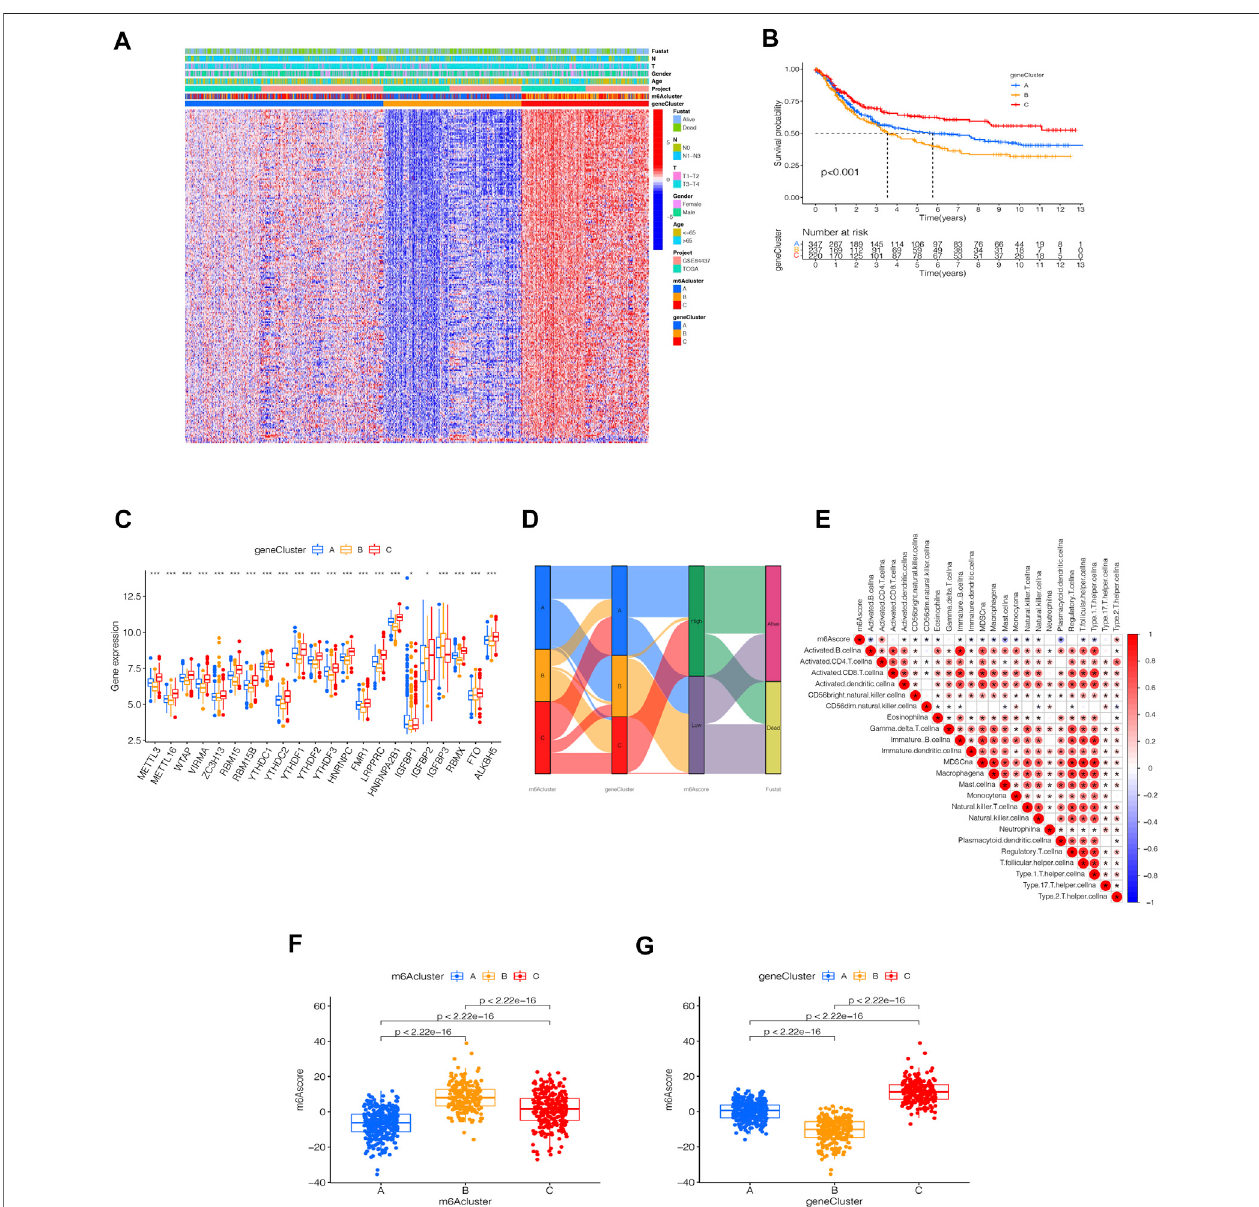
FIGURE 5 | Identi fi cation of m6A-related genes ’ phenotypes and m6A scores. (A) Heat map of genetic modi fi cation patterns. (B) Survival curves of different geneclusters ( p < 0.0001, Log-rank test). (C) Box plot of the differential expression analysis of m6A-related genes among different geneclusters. The asterisks representedthestatistical p value( ppp p < 0.0001, pp p < 0.01, p p < 0.05).Theone-wayANOVAtestwasusedtotestthestatisticaldifferencesamongthreegeneclusters. (D) Sankey diagrams of different genotypes. (E) Correlation analysis between the m6A score and immune cells, with red indicating positive correlation and blue indicating a negative correlation. The Kruskal-Wallis test was used to compare the statistical difference between three gene clusters ( p < 0.001). (F) Differential expression analysis of the m6A score in the m6A cluster. (G) Difference analysis of m6A score in genecluster ( p < 0.001, Kruskal-Wallis test)